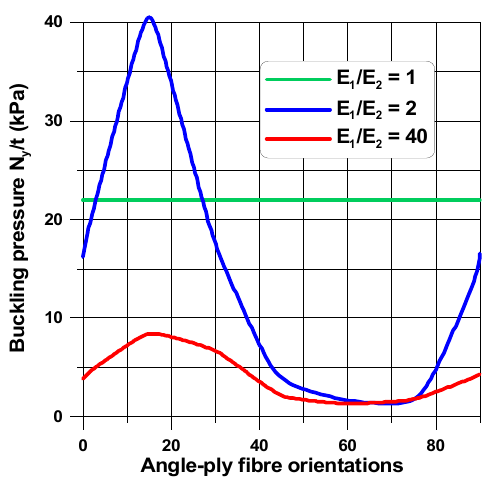
Figure 14. Distributions of buckling loads with fibre orientations ( θ ) and the orthotropic parameter, β = E 1 / E 2 , G 12 / E 1 = 0.015 for the square plate with the elliptical horizontal hole 2 b / L x = 0.4, b / a = 2.